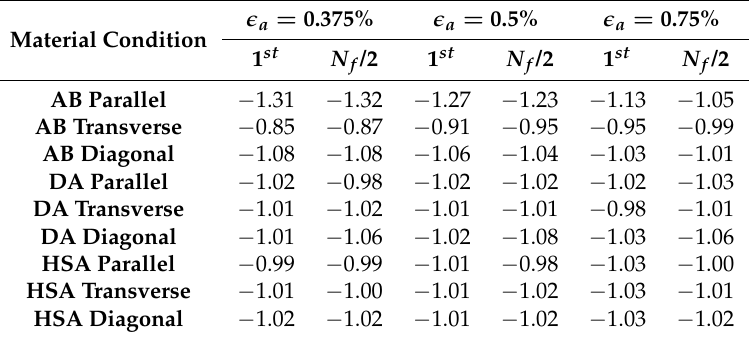
Table 6. Stress ratio ( R σ ) evolution with respect to different applied strain